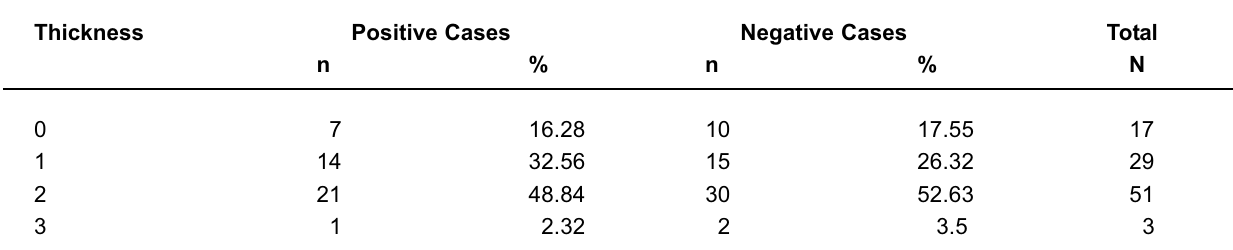
Chi-square test ( χ 2 = 0.536),